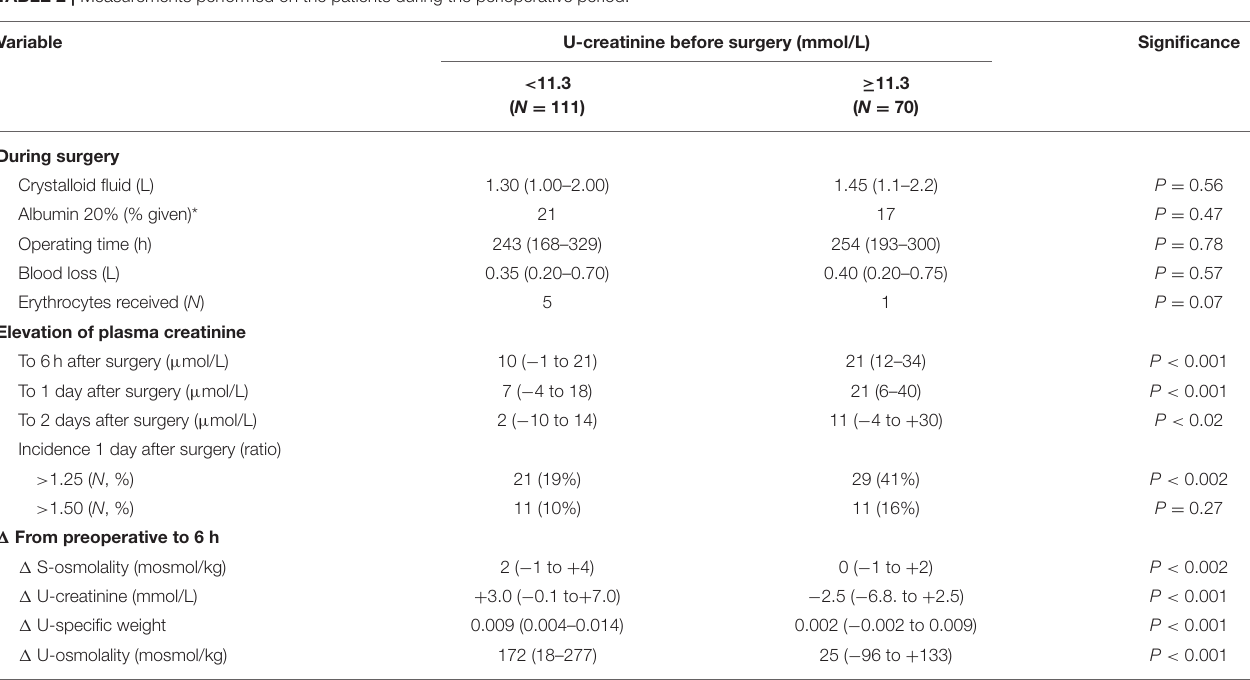
TABLE 2 | Measurements performed on the patients during the perioperative